Question: From the figure, is the trend upward or downward?
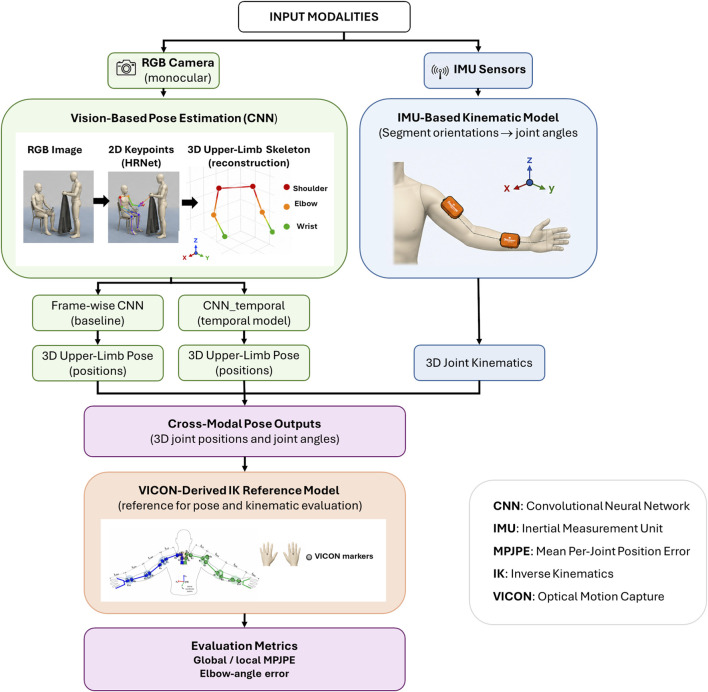
Answer: increasing